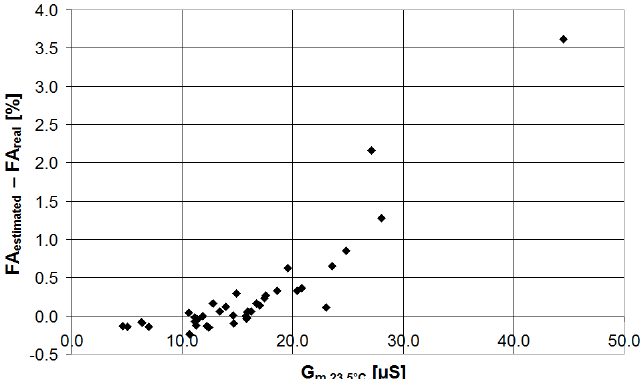
Figure 10. Error in the estimated free acidity plotted as a function of the emulsion electrical conductance at 23.5 °C using DW as reagent for the full set of 40 olive oil samples.